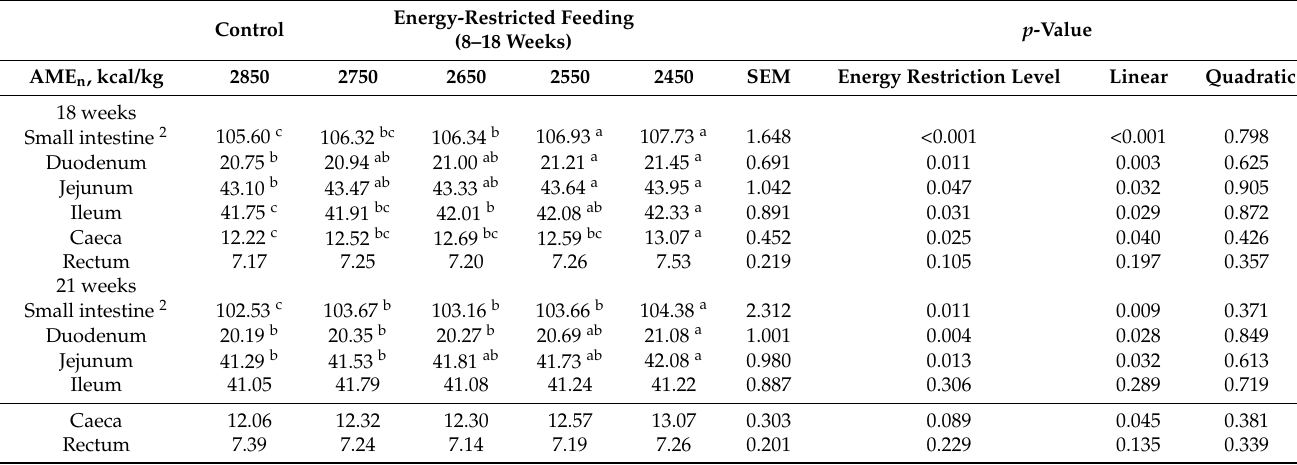
Table 8. Effects of energy-restricted feeding and switching to ad libitum feeding on the relative length of the GIT (cm/kg BW) of the pullets at 18 and 21 weeks of age.